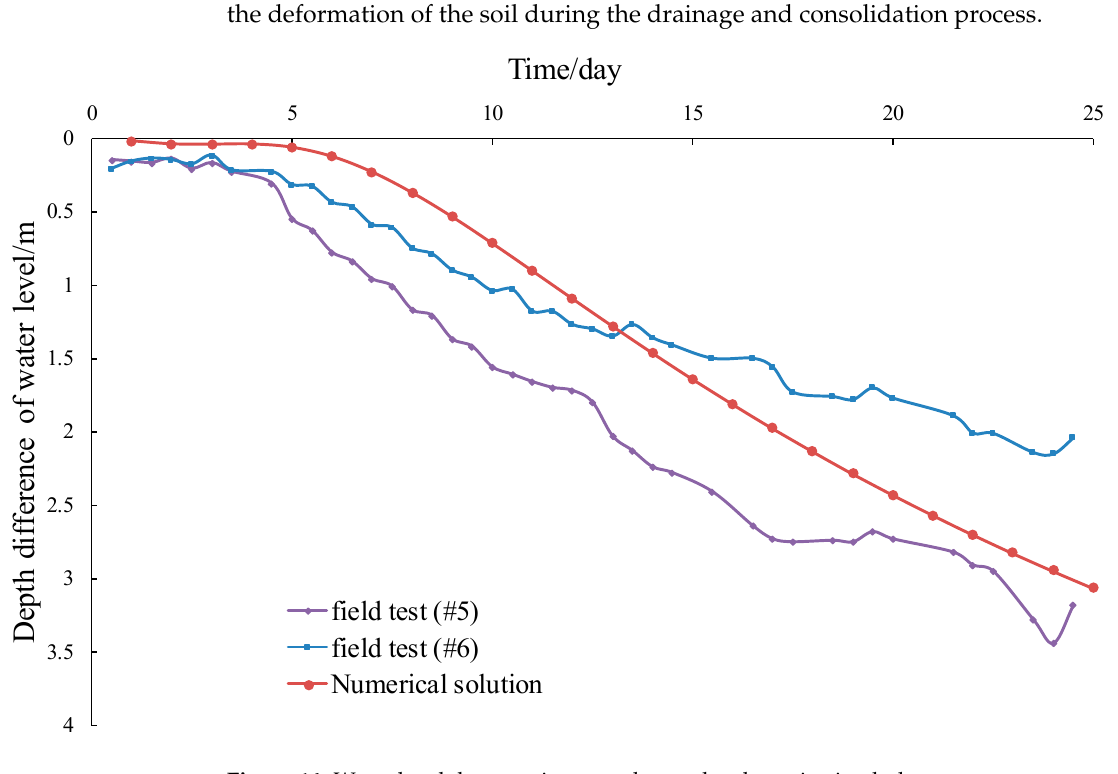
Figure 14. Water level decrease in groundwater level monitoring holes.